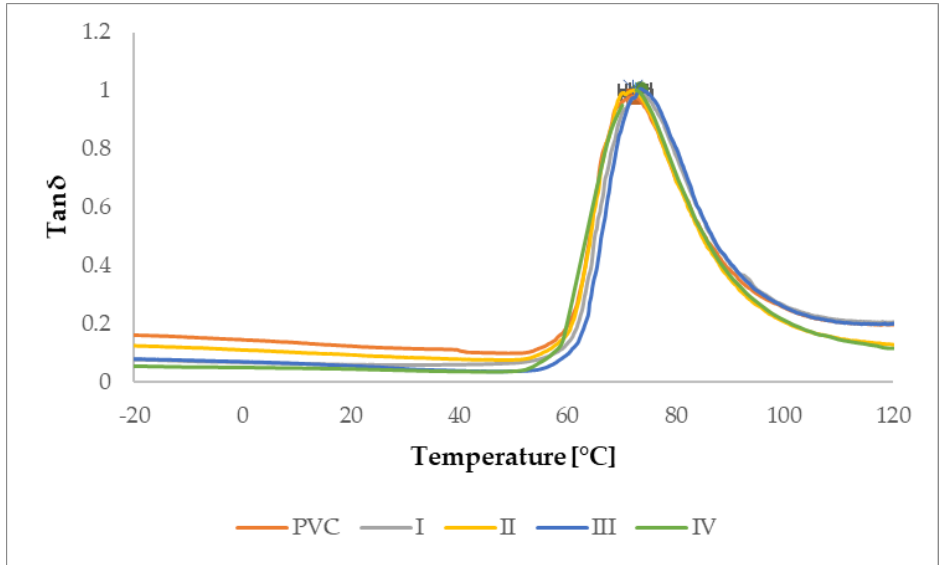
Figure 17. Determined curves of the Loss modulus of the sample PVC, I, II, III, IV.